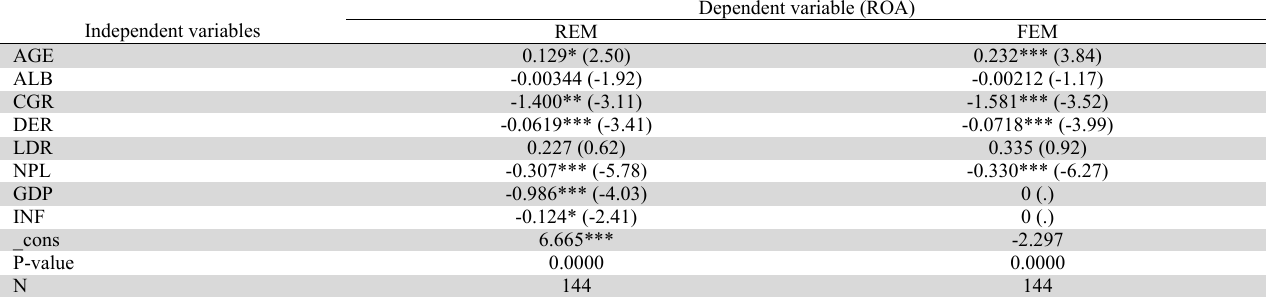
Regression results for factors affecting profitability Independent